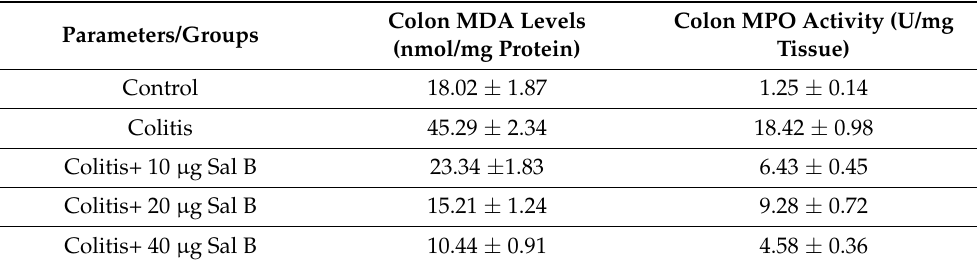
Table 2. Effect of Sal B on colon MDA levels, and MPO